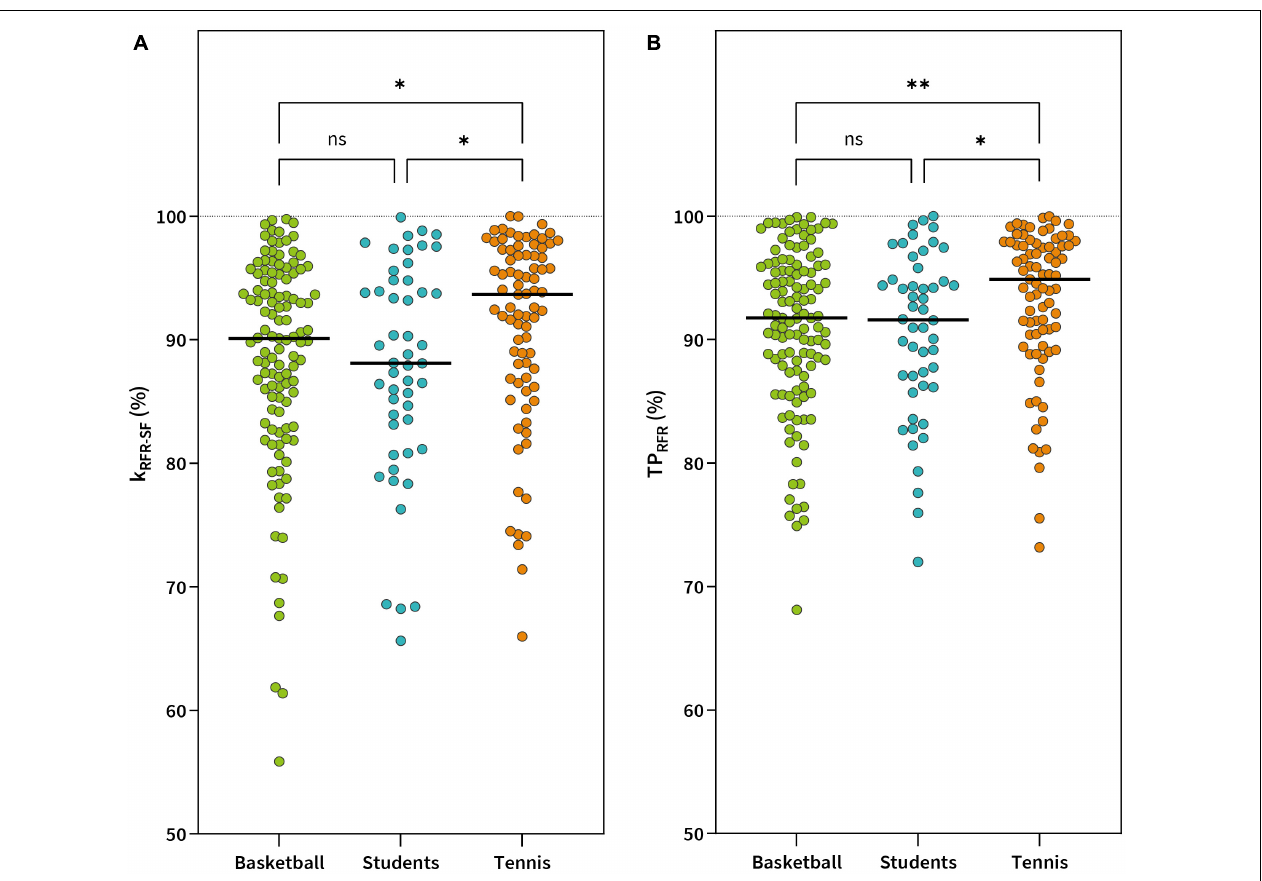
FIGURE 5 | Between sports comparison of symmetry values for RFR-SF slope (k RFR − SF ) (A) and theoretical peak rate of force relaxation (TP RFR ) (B) . ∗∗ p < 0.01; ∗ p < 0.05; ns, not